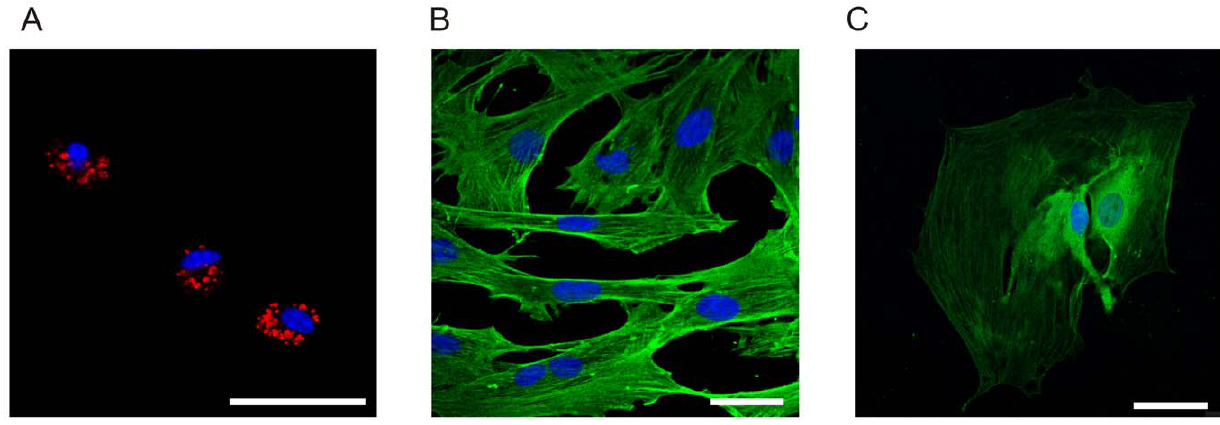
Figure 1. PSC phenotype. A. Nile red lipid staining at day 2. B. a SMA antibody staining at day 7. C. GFAP antibody staining at day 7. Secondary antibody was conjugated to Alexa 488 (green) and nuclear stain was DAPI (blue). Representative images of 3 independent experiments. Scale bars are 50 m m.